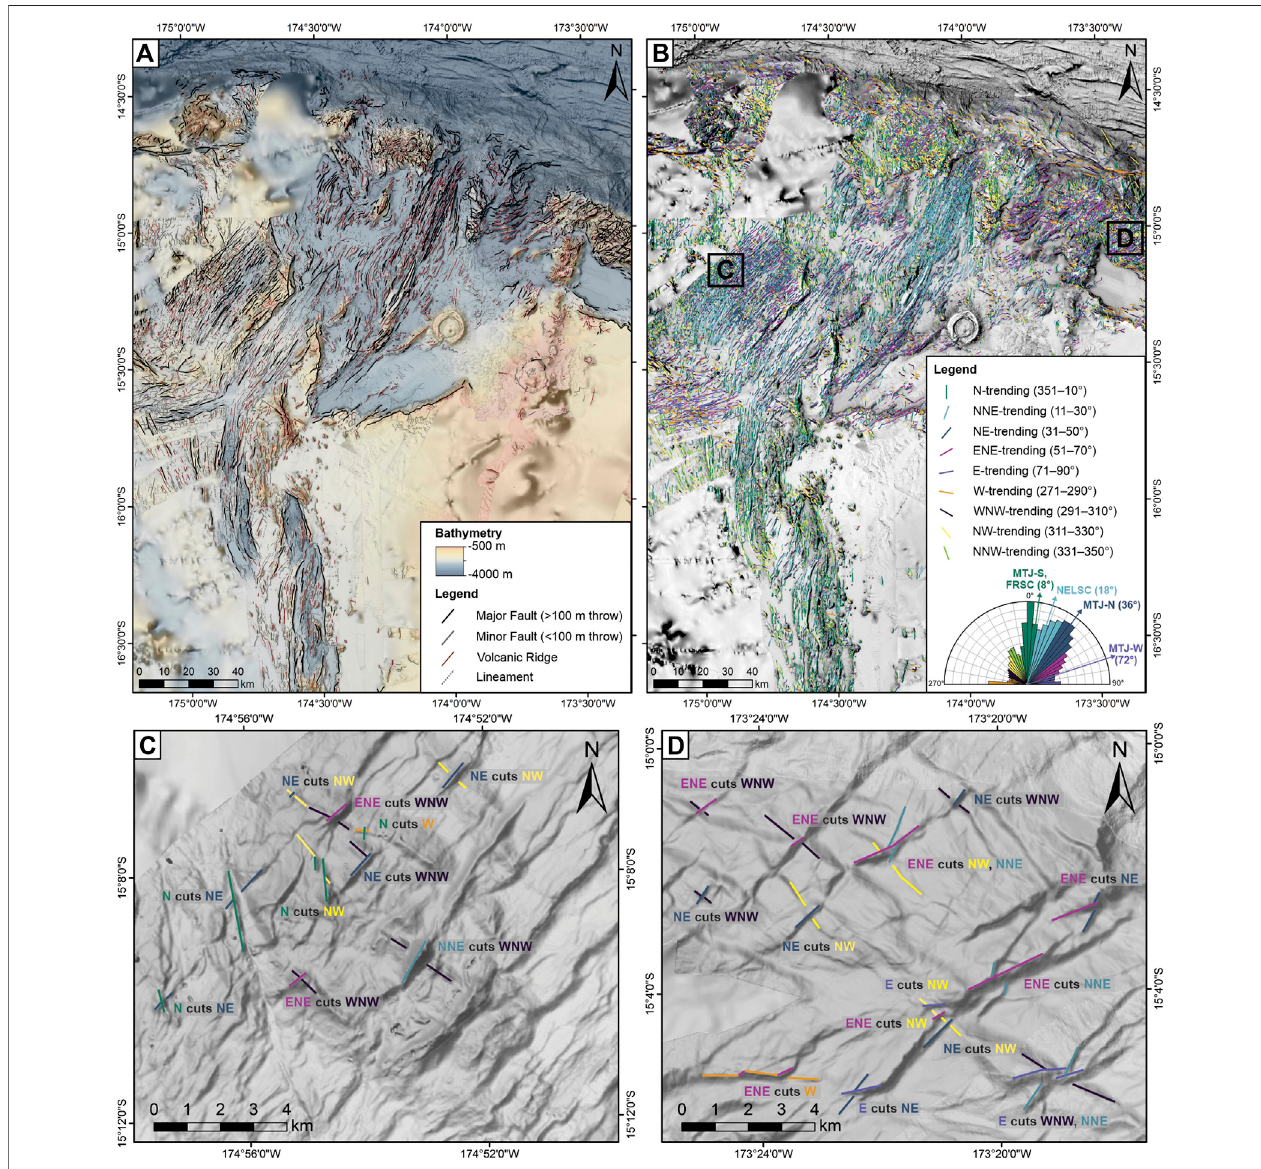
FIGURE 6 | Manually interpreted structural lineaments (mapped at a resolution of 1:100,000) in the NE Lau basin overlain on a compilation of ship multibeam bathymetry (compilation data as in Figure 3 ): (A) by type, and (B) by orientation. Examples of cross-cutting relationships of selected structures are shown in close-ups for (C) the NW rift zone, and (D) the paleo-arc crust, summarized in Table 1 . Higher-resolution maps are provided in Supplementary Figures S6 – S31 .